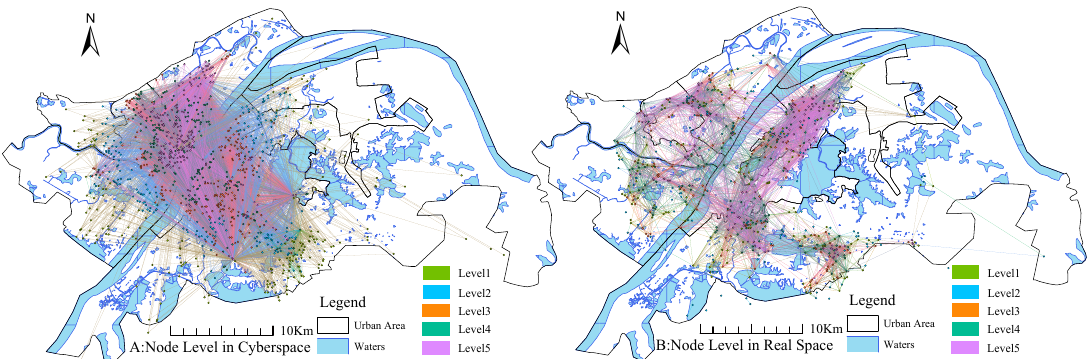
Figure 10. Spatial distribution characteristics of key nodes.